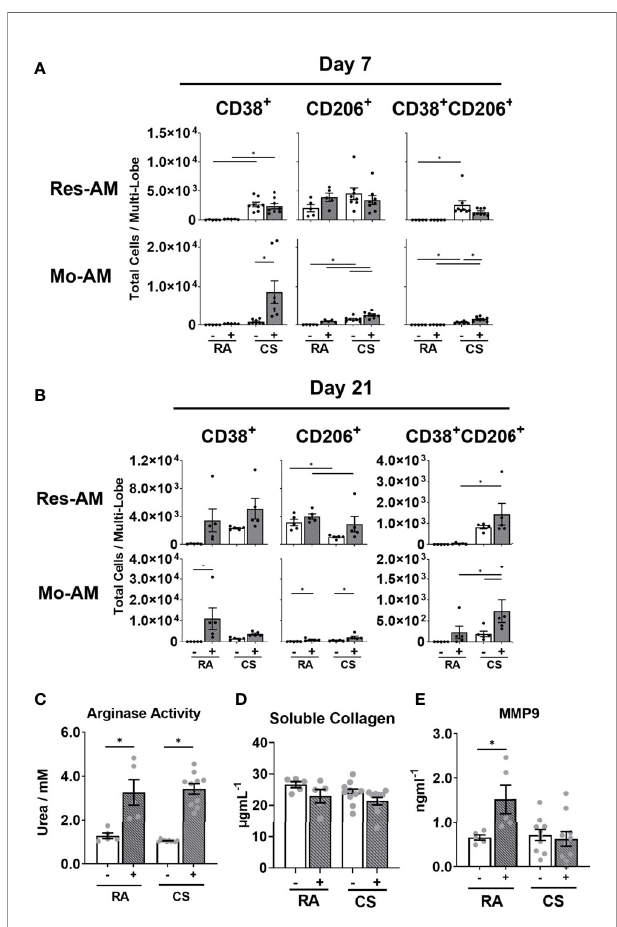
FIGURE 6 | Macrophage subpopulation function and polarisation is altered by cigarette smoke exposure. C57BL/6 female mice were administered bleomycin (0.05U/mouse) (grey bars) or saline control (open bars) following 12-weeks of RA or CS exposure. Total number of Res-AM and Mo-AM expressing CD38, CD206 and CD38/CD206 in lung tissue following (A) 7 days or (B) 21 days post bleomycin administration. Adherent lung CD45 + cells isolated from 12- week RA- or CS-exposed C57BL/6 cell supernatant (C) urea production, (D) soluble collagen and (E) MMP9 release following TGF- b 1, IL-4, IL-6 stimulation. Data show mean ± SEM, n= 5-10. Two-way ANOVA with Tukey ’ s multi-comparison test. RA, room air; CS, cigarette smoke. *p < 0.05. “ - ” represents saline administration (A – E) . "+" represents 0.05U bleomycin administration (A, B) or TGF-b1, IL-4, IL-6 administration (C – E)